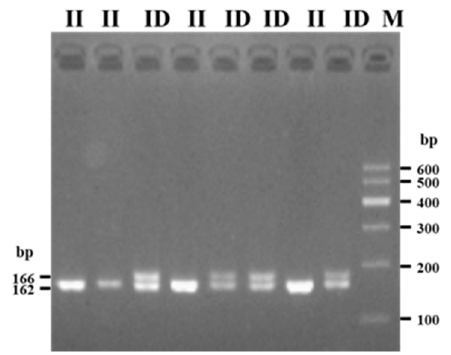
Figure 1. Agarose electrophoresis of goat Sox9- 4 bp insertion/deletion (indel).